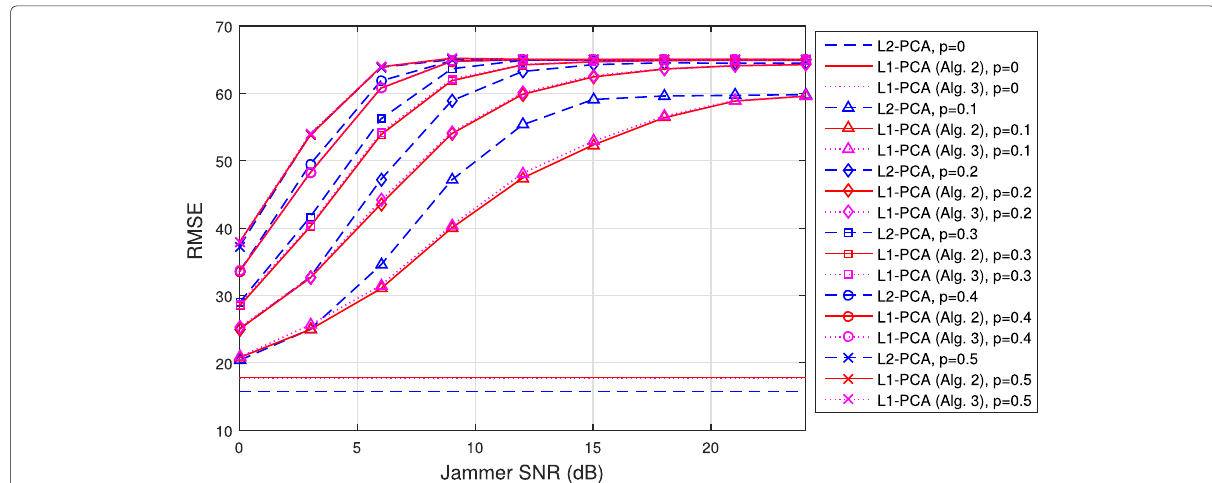
Fig. 6 Root-mean-squared-error (RMSE) vs. jammer SNR, for: L2-PCA (MUSIC), optimal L1-PCA, calculated by means of Algorithm 2 in Fig. 3, and L1-PCA by means of Algorithm 3 in Fig. 4. For each estimator, we present the RMSE curves for p = 0,.1,.2,.3,.4,.5. N = 8, D = 3, θ = − 41 ◦ , θ (cid:13) = 24 ◦ , source SNR 2